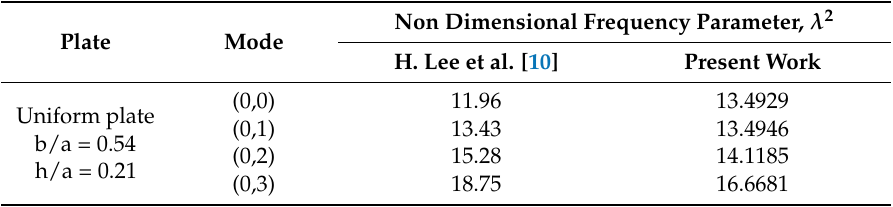
Table 2. Validation and comparison of natural frequency parameter λ 2 of uniform clamped-free annular circular plate obtained in the present work with that of the published result of Lee et al.